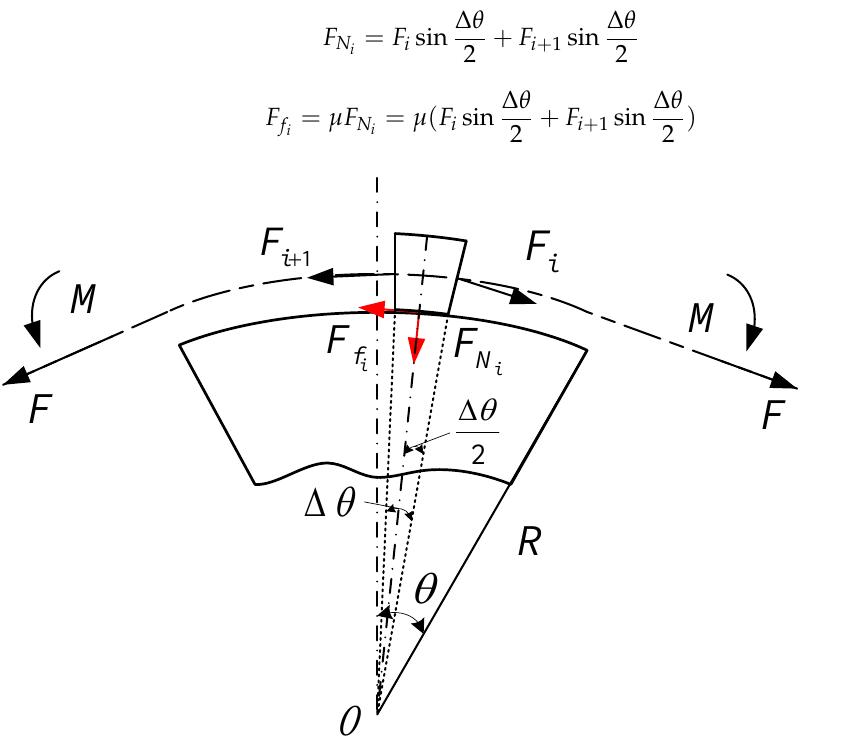
Figure 2. Force analysis of micro-unit at point A.